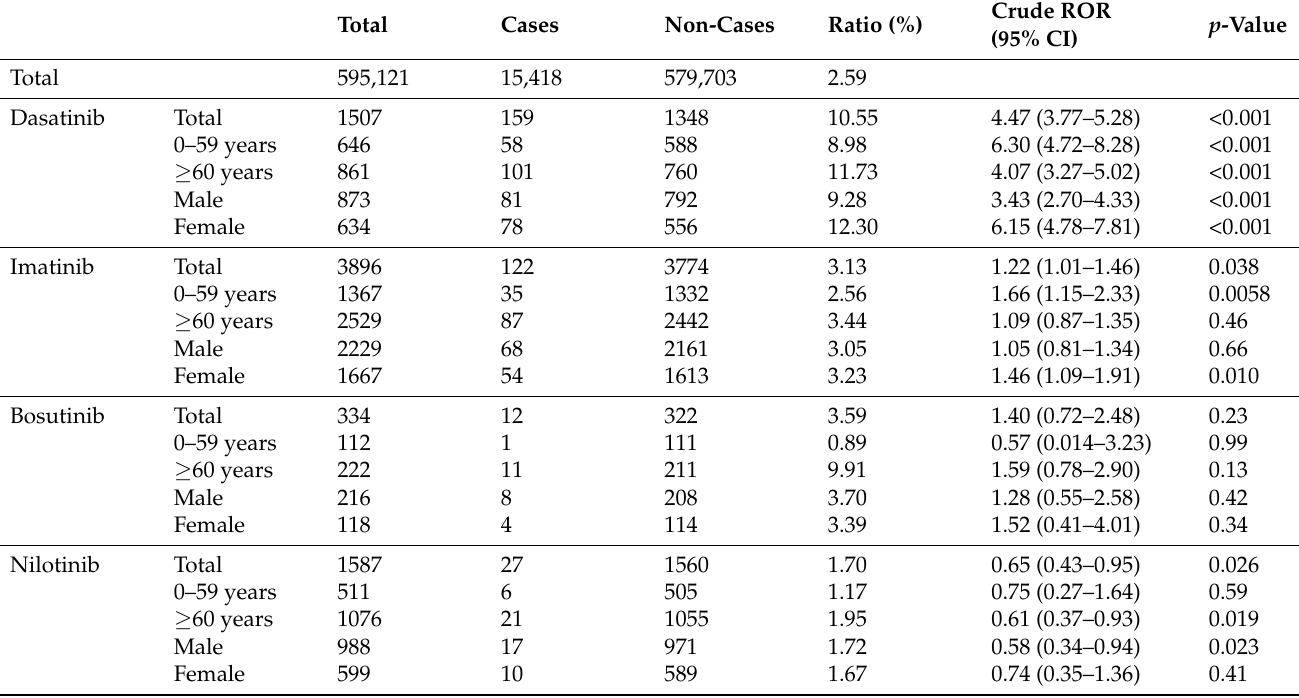
Table 1. Reported cases and the crude reporting odds ratios (RORs) of gastrointestinal